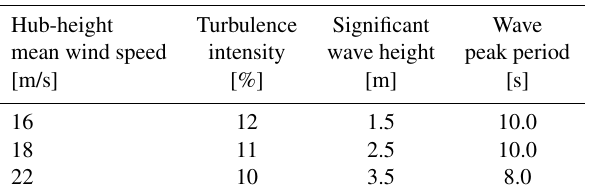
Table 1. Metocean conditions considered for the verification of the wave-FF control